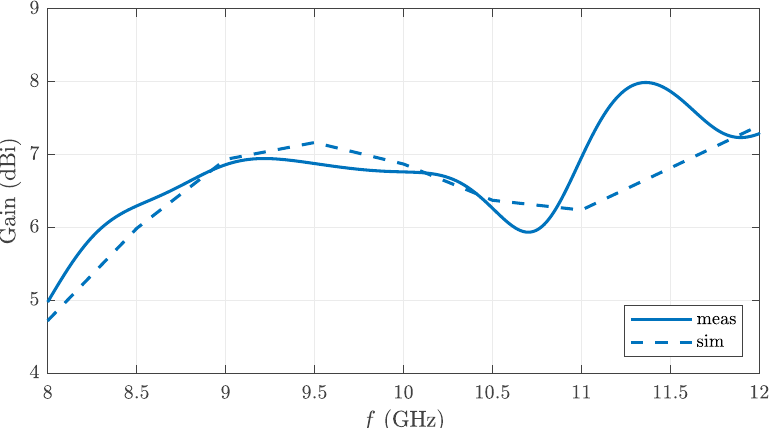
Figure 11. Simulated and measured gain of the main lobe versus frequency.